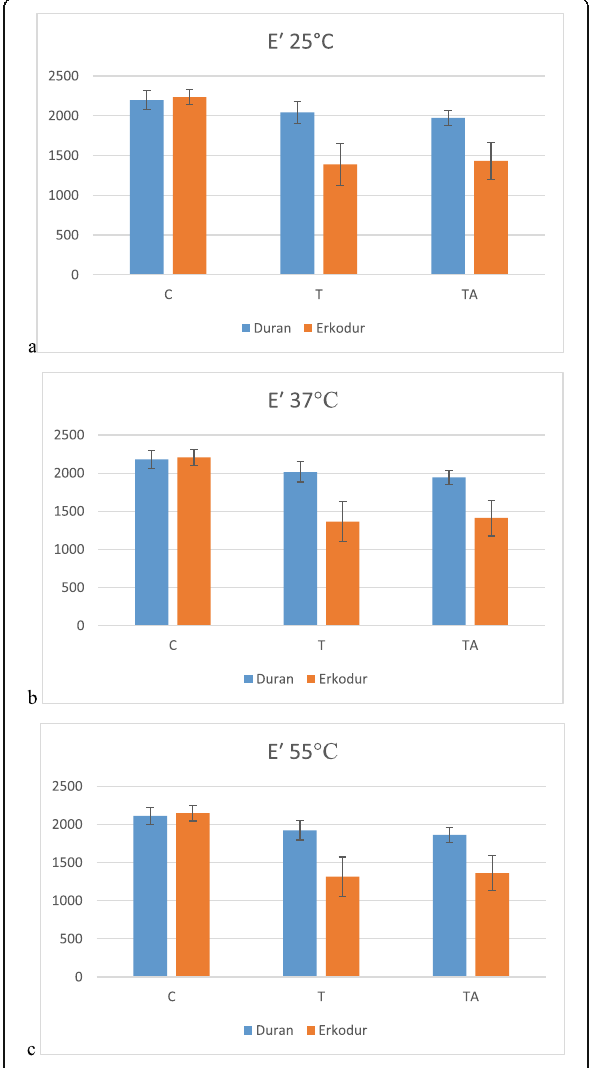
Fig. 6 Changes in elastic modulus at a 25°C, b 37°C, c